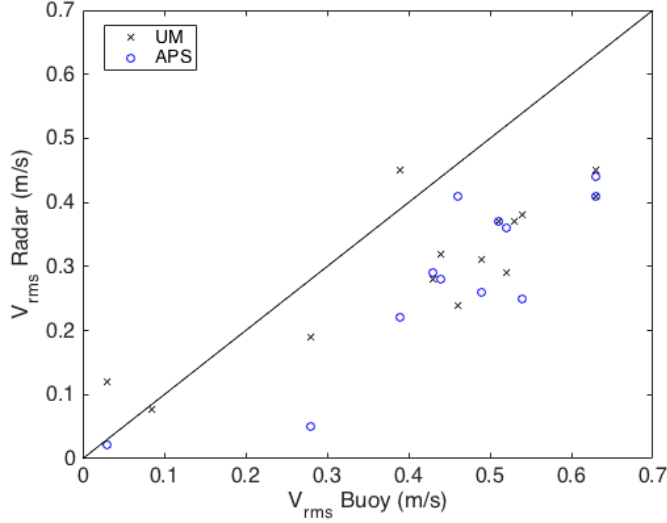
Figure 9. Scatterplot of V rms derived from APS radar ( ) and UM radar ( × ) POD orbital velocity reconstructions versus the buoy-based V rms . The solid line shows the 1:1 line for reference.